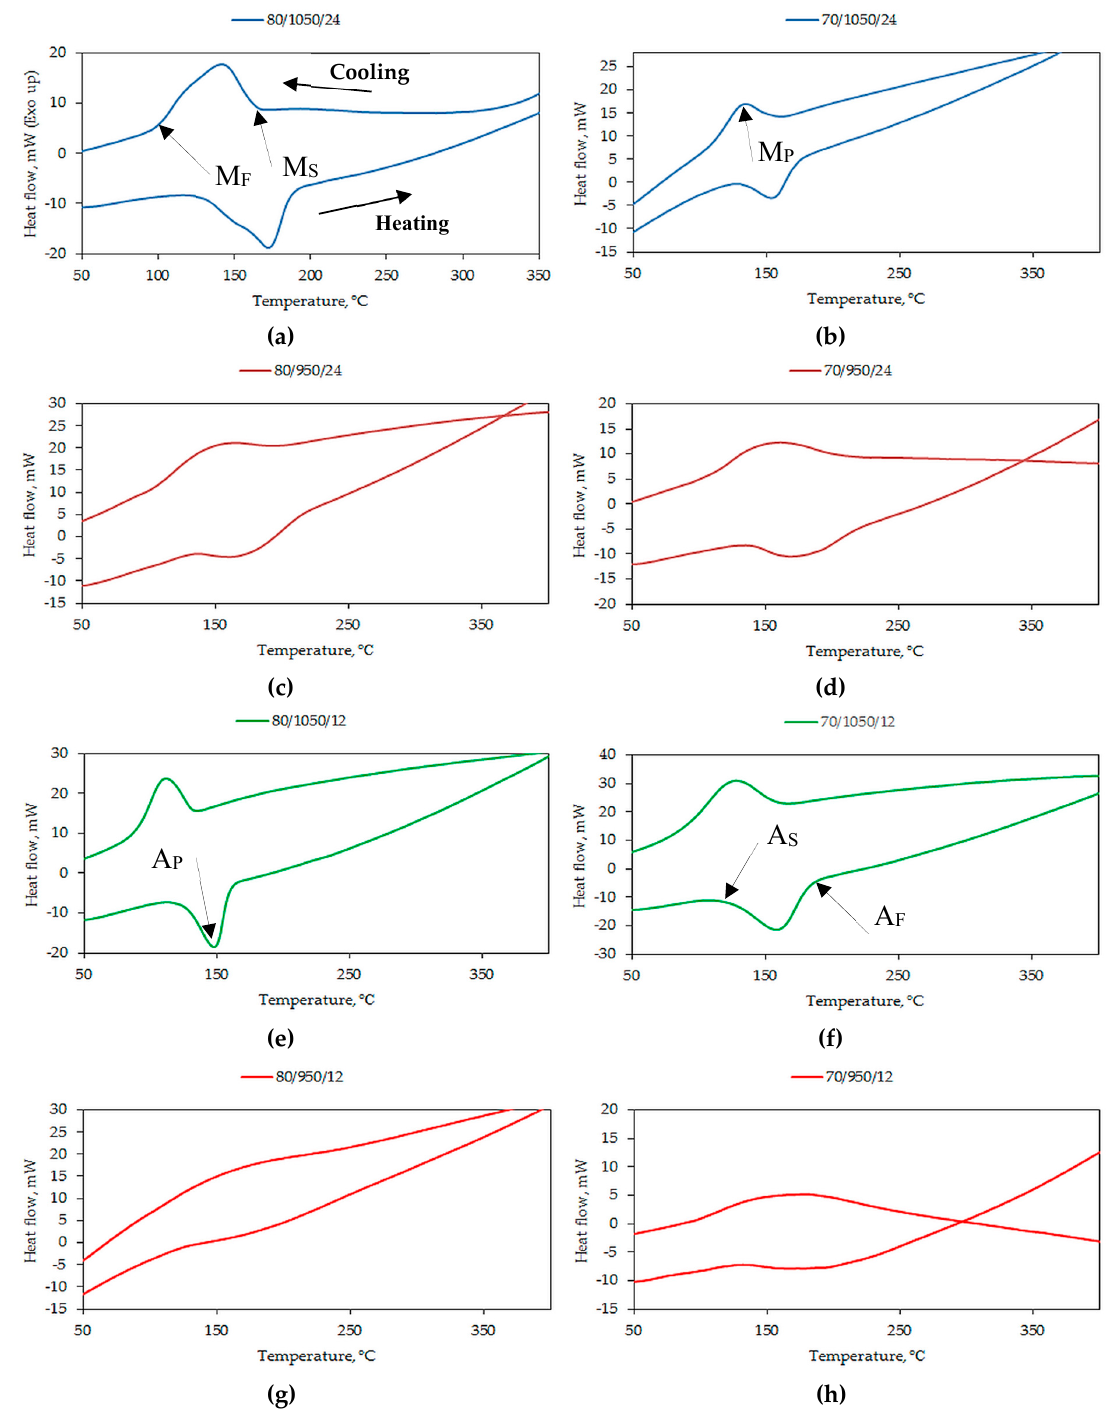
Figure 6. DSC curves of: ( a ) S1050b2; ( b ) S1050a2; ( c ) S950b2; ( d ) S950a2; ( e ) S1050b1; ( f ) S1050a1; ( g ) S950b1; and ( h ) S950a1.